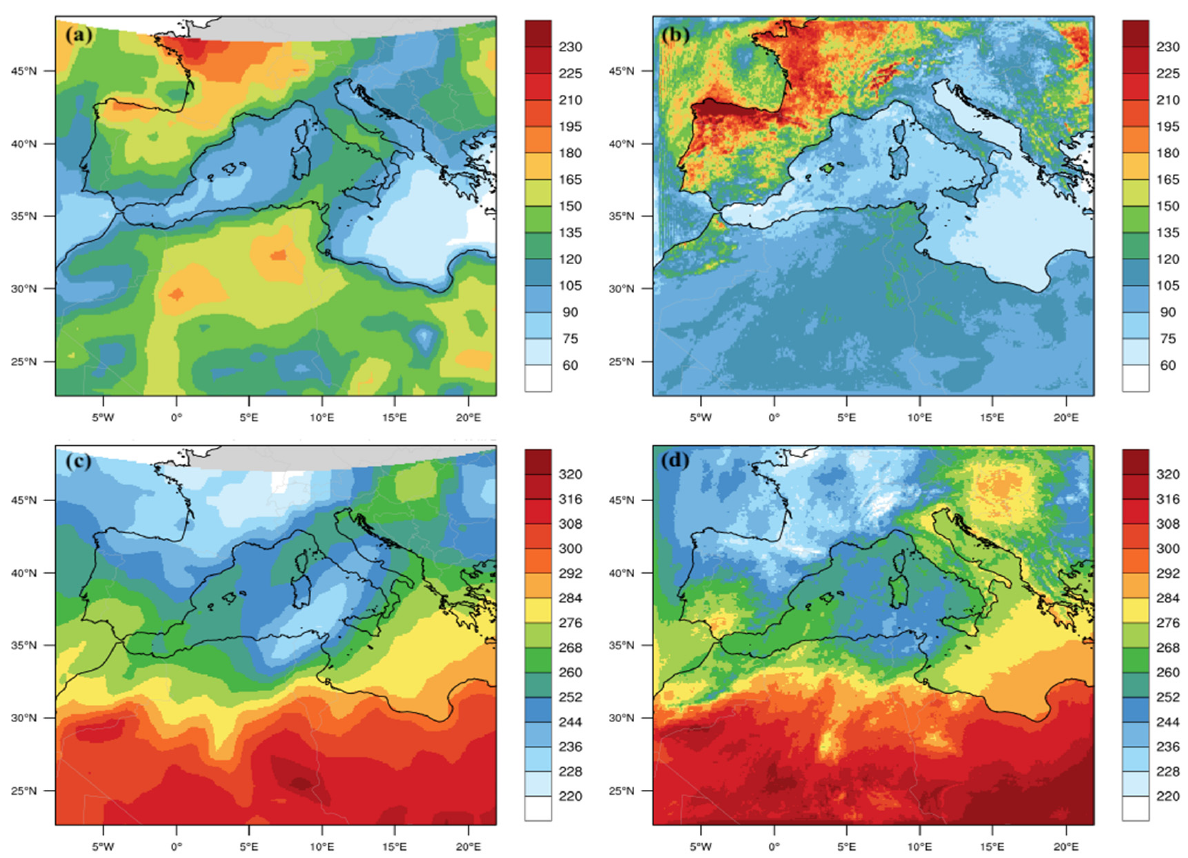
Figure A1. Period average (17–24 June 2021) of the observed (CERES) SW at TOA ( a ) and modelled (FULL) upwelling SW radiative flux at TOA ( b ); period average (17–24 June 2021) of the observed (CERES) at TOA ( c ) and modelled (FULL) upwelling LW radiative flux at TOA ( d ). Units are W m − 2 .